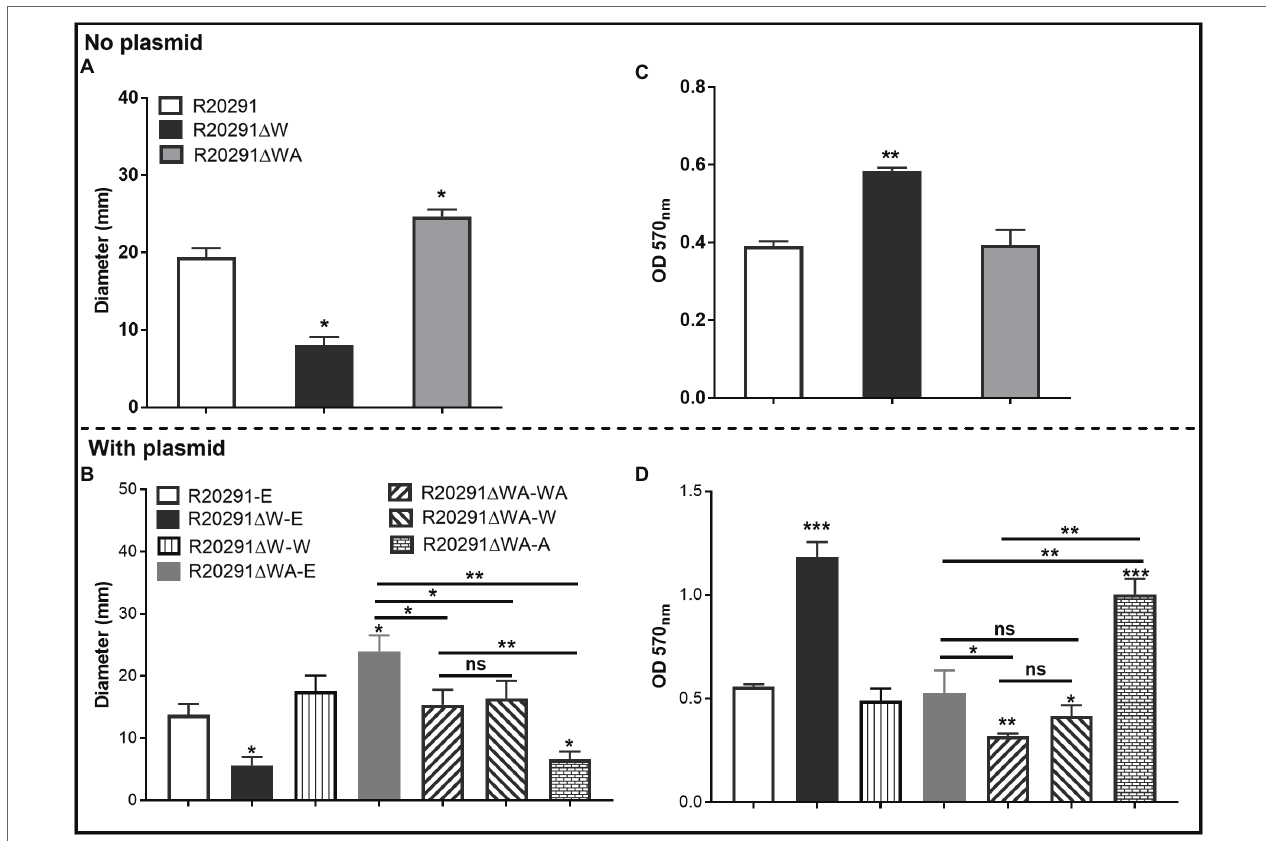
FIGURE 2 | Motility and biofilm analysis. (A,B) : Halo diameter of motility (swimming analysis on 0.175% agar plate). (C,D) : Biofilm formation analysis. Bars stand for mean ± SEM (* p < 0.05, ** p < 0.01, and *** p < 0.001). One-way ANOVA with post hoc Tukey test was used for statistical significance. ***directly upon the column means the significant difference of the experimental strain compared to R20291 or